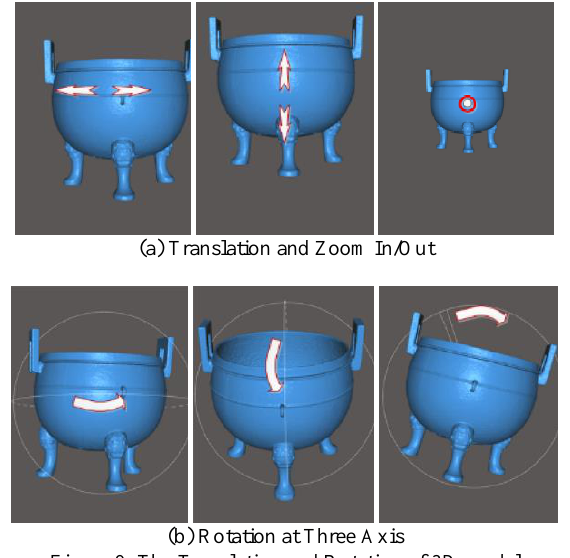
Figure 9. The Translation and Rotation of 3D